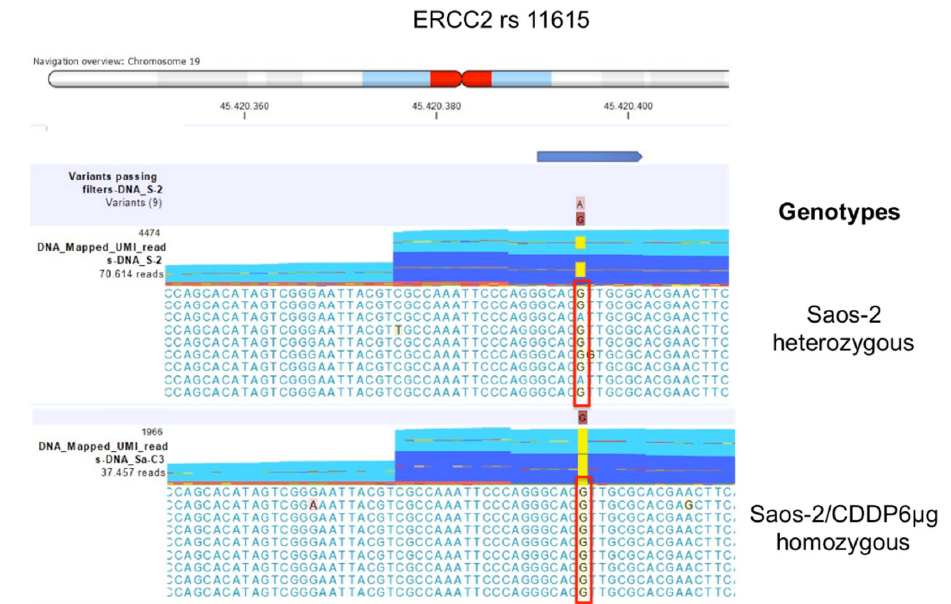
Figure 5. ERCC1 rs11615 genotypes identified by multimodal targeted next generation sequencing (mmNGS) in Saos ‐ 2 cell line and Saos ‐ 2/CDDP6 μ g variant. Mismatched nucleotides are evidenced by the CLC Genomics Workbench (GWB) with a background color according to the Rasmol color scheme. The red square box indicates the polymorphism alleles.